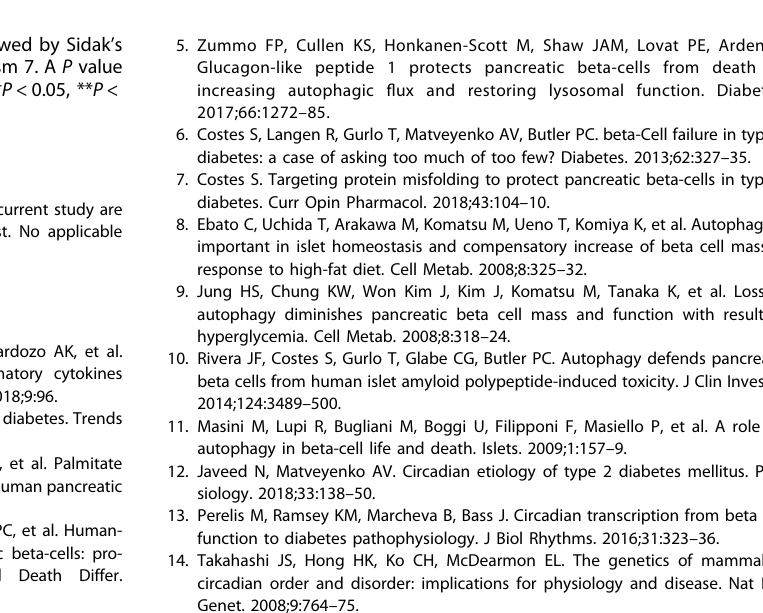
Fig. 9 REV-ERB α preferentially binds to promoter regions of genes regulating protein degradation and autophagy in T2DM human islets. A Schematic outlining digital genomic transcription factor (TF) footprinting from ATAC-seq of ND and T2DM islet samples (SRP117935) [35]. Transcription factors (e.g., REV-ERB α ) protect against Tn5 digestion, resulting in a local decrease in chromatin accessibility ( ‘ footprint ’ ). This enables for identi fi cation and differential analysis of transcription factor binding at regulatory motifs in non-diabetic (ND) versus Type 2 Diabetic (T2DM) islets using the Hmm-based IdeNti fi cation of Transcription factor footprint framework (HINT) [36]. B Venn diagram highlighting the overlap of REV-ERB α footprints identi fi ed in promoter regions (±1 kb from TSS) from at least two ND and/or T2DM islet samples ( n = 5 ND and n = 5 T2DM samples). C – E (left): Representative ND and T2DM REV-ERB α footprints uniquely observed in T2DM islets (top), uniquely in ND islets (middle), and common (bottom) in both ND and T2DM islets within promoter regions. The signal is normalized to the total read depth of each sample and is plotted ±35 bp from the REV-ERB α motif center. C – E (right): Enriched GO: Biological Process pathways annotated from T2DM unique (top), ND unique (middle), and common (bottom) REV-ERB α footprints in promoter regions. F Forrest plot illustrating results of the meta-analysis for genes annotated as REV-ERB α footprints (unique to T2DM) derived from 5 publicly available human islet microarray datasets comparing the transcriptome of non-diabetic and type 2 diabetic islets (GSE38642 [63], GSE 25724 [64], GSE20966 [65], GSE76894 [66], and GSE76895 [66]). Red arrows highlight common genetic regulators of autophagy and protein degradation in